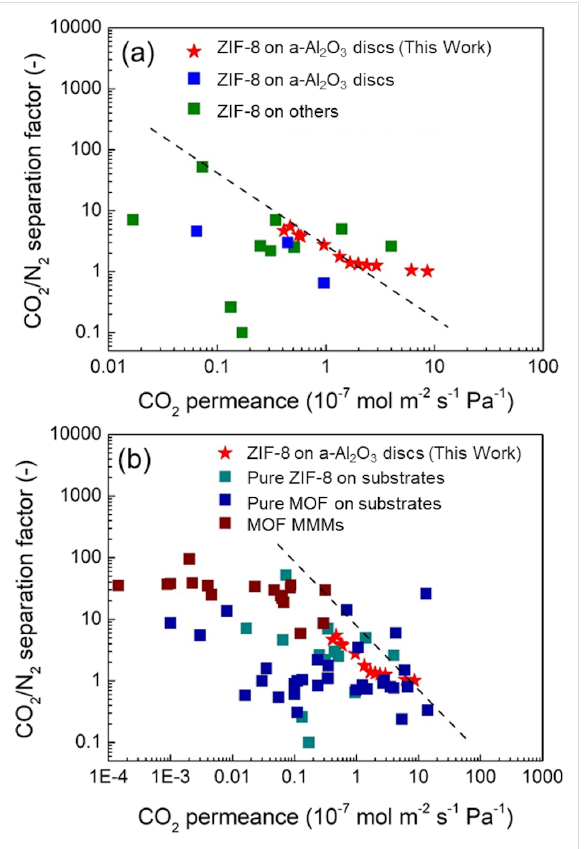
Figure 8: Gas separation performance (CO 2 /N 2 ) of the ZIF-8 mem- branes on α -Al 2 O 3 disks (red stars, this work) compared with (a) ZIF-8 membranes on α -Al 2 O 3 disks (blue squares) [46-48] and ZIF-8 mem- branes on other substrates (green squares) [49-59], and (b) pure ZIF-8 on substrates (turquois squares) [46-59], MOF membranes supported on substrates (blue squares) [50,60-84], and MOF mixed matrix mem- branes (brown squares)